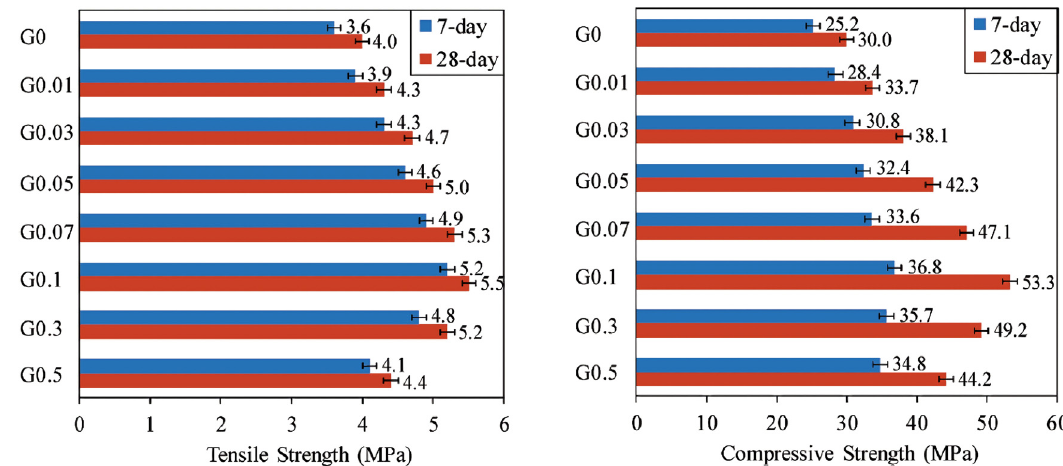
Figure 13: Variation of 7 and 28 days tensile and compressive strength of GO - cement mortar with di ff erent GO contents [ 75 ]